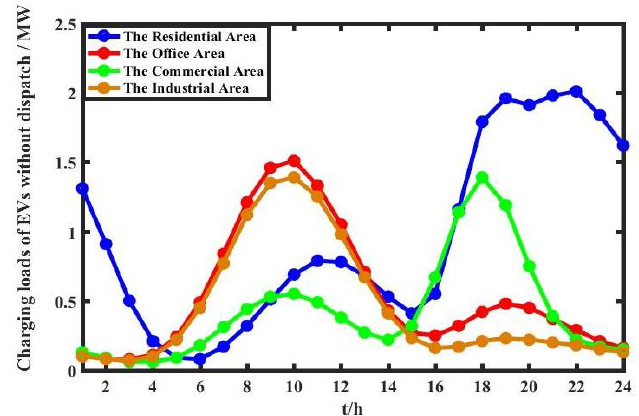
Figure 4. Predicted charging loads of EVs of multiple functional areas.